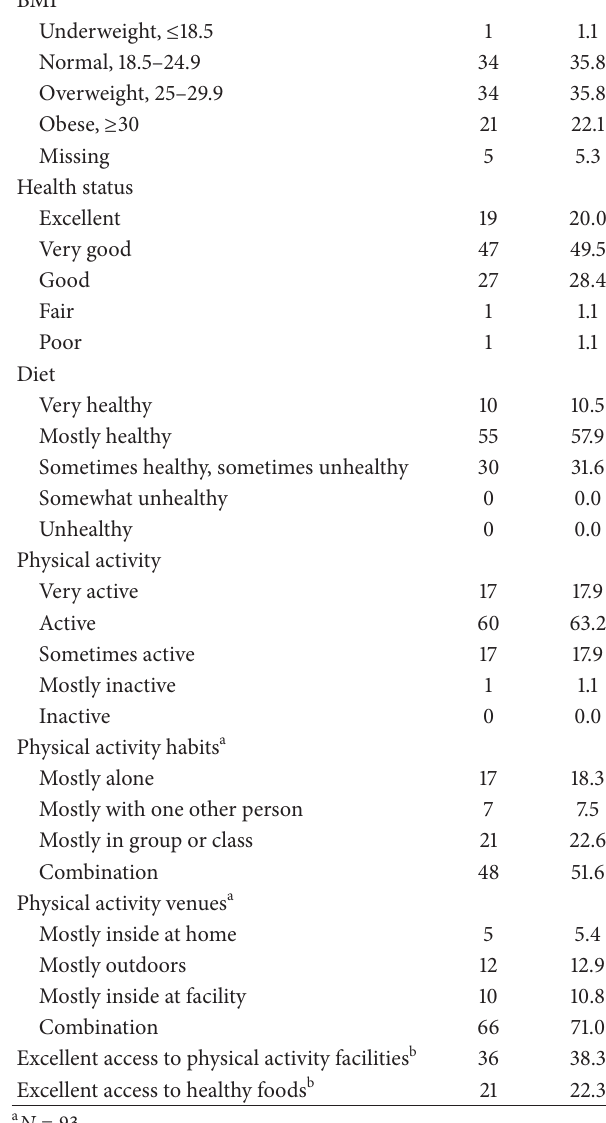
Table 1: Themes and subthemes identified through focus groups.